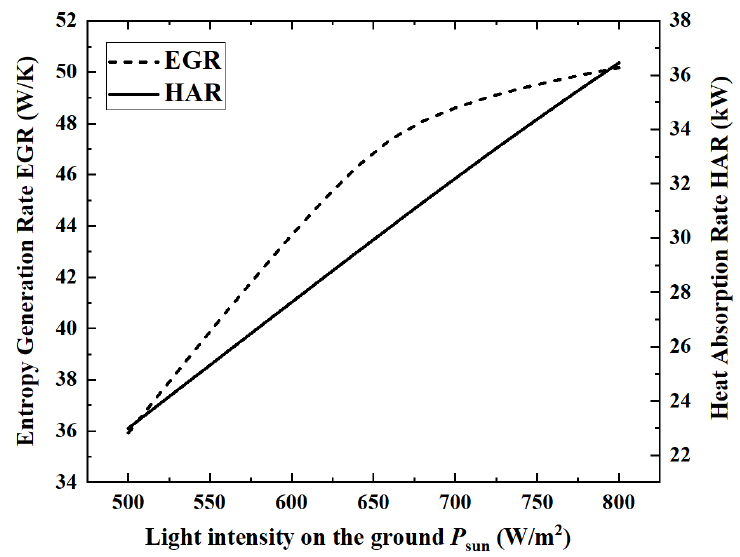
Figure 6. Effect of light intensity on EGR and HAR.